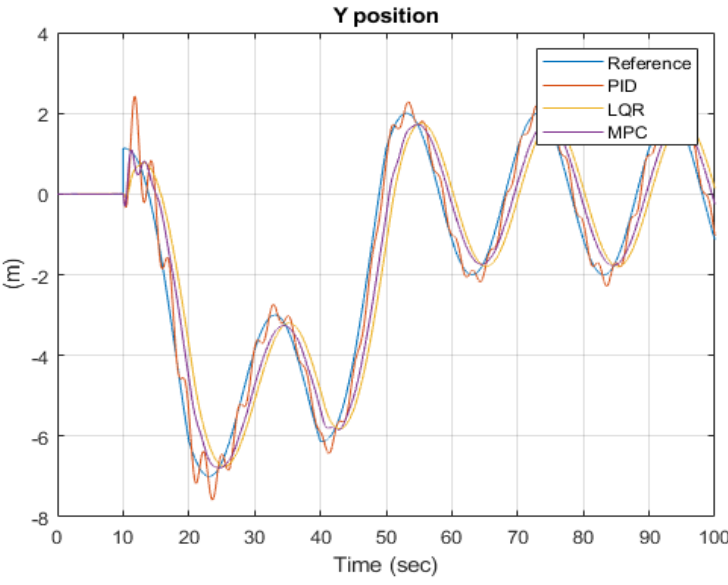
Figure 5. Performance of the controllers along y axis in simulation.